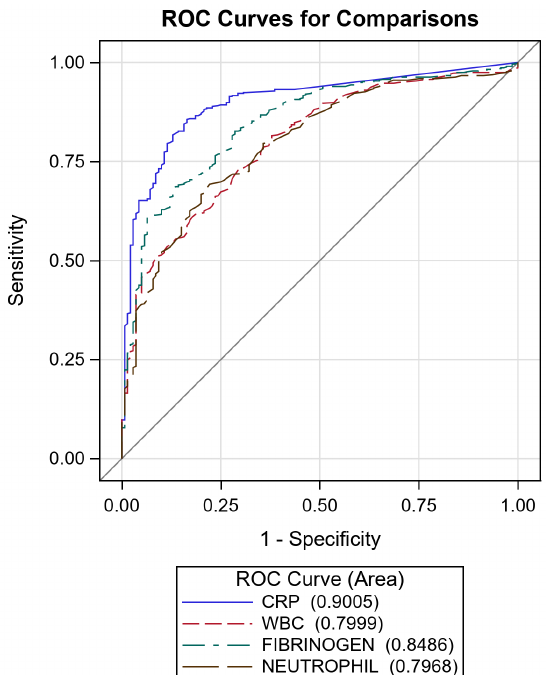
Figure 3. Receiver Operating Characteristic curves of C-reactive protein (CRP) (AUC 90.0%, 95% CI: